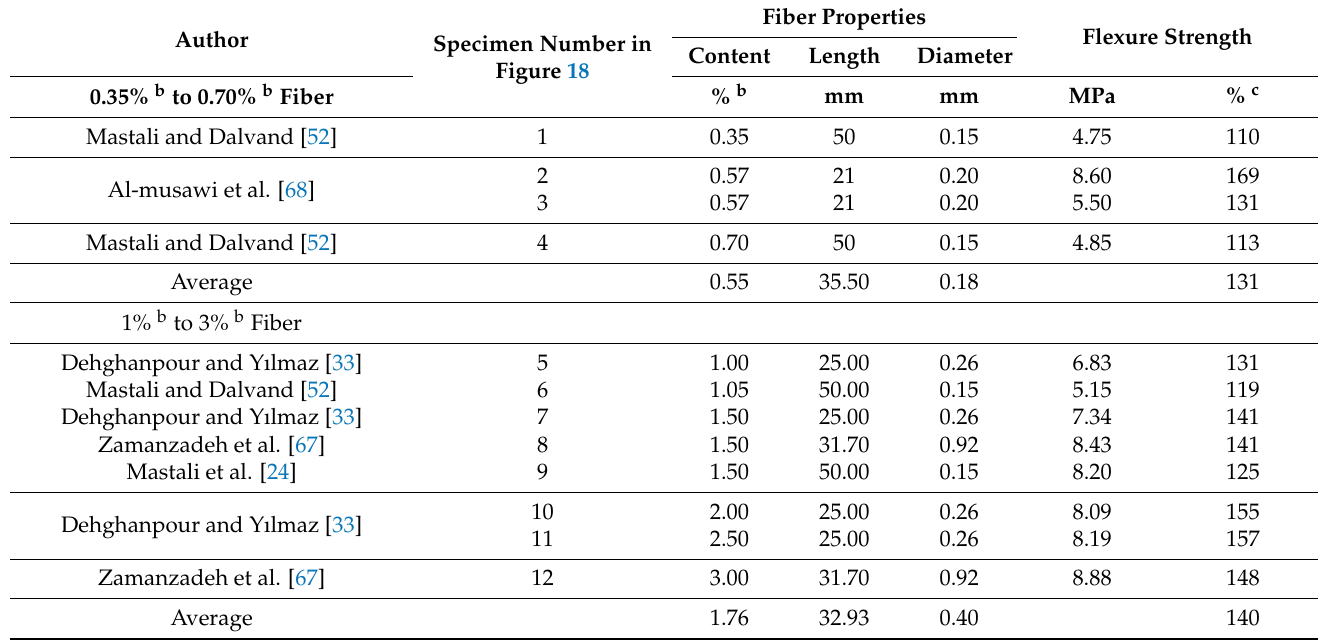
Table 13. Results of flexure strength’s percent comparison and fiber properties of the cement mortar incorporating RSF by volume